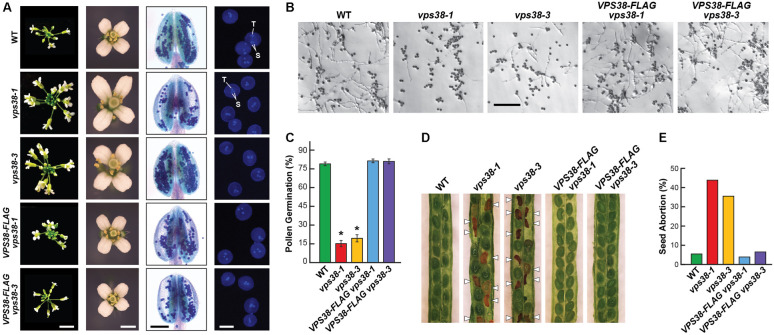
VPS38 is required for robust reproduction. (A)
vps38 mutants have altered inflorescence morphology but produce viable pollen. Shown are representative inflorescence apices, flowers, anthers, and pollen grains from WT, vps38-1, vps38-3, and VPS38-FLAG complementation plants grown for 50 days under a LD photoperiod. The anthers were incubated with Alexander stain to label viable pollen. Pollen grains were stained with DAPI to locate nuclei. T, tube nucleus; S, sperm nuclei. Scale bars = 1 cm, 1 mm, 100 μm, and 20 μm, respectively. (B) Germination of vps38 pollen is depressed. Pollen grains from just opened flowers were incubated on pollen germination medium for 10 h. Scale bar = 300 μm. (C) Quantification of the percent germination for pollen shown in (B). Each bar represents the average (±SD) of three independent analyses, each consisting of >300 pollen grains from 10 anthers. Asterisks indicate significant differences from WT by Student’s t-test (p-value < 0.01). (D)
vps38 mutants display enhanced seed abortion. Shown are self-fertilized siliques from homozygous vps38-1 and vps38-3 plants as compared to WT or the corresponding VPS38-FLAG complementation lines. Aborted seeds are indicated by the arrowheads. (E) Quantification of the abortion rate for self-fertilized siliques as shown in (D). The bars represent the means of 460–902 seeds measured from 25 to 45 siliques of each genotype.